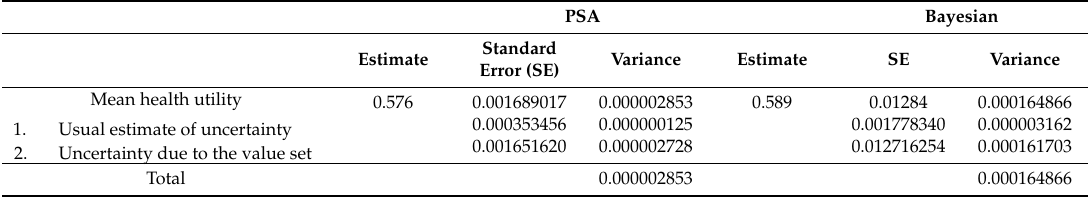
Table 2. Impact of parameter uncertainty in the value set on estimates of a population’s mean health utility. PSA Bayesian Standard Estimate Variance Estimate SE Variance Error (SE) Mean health